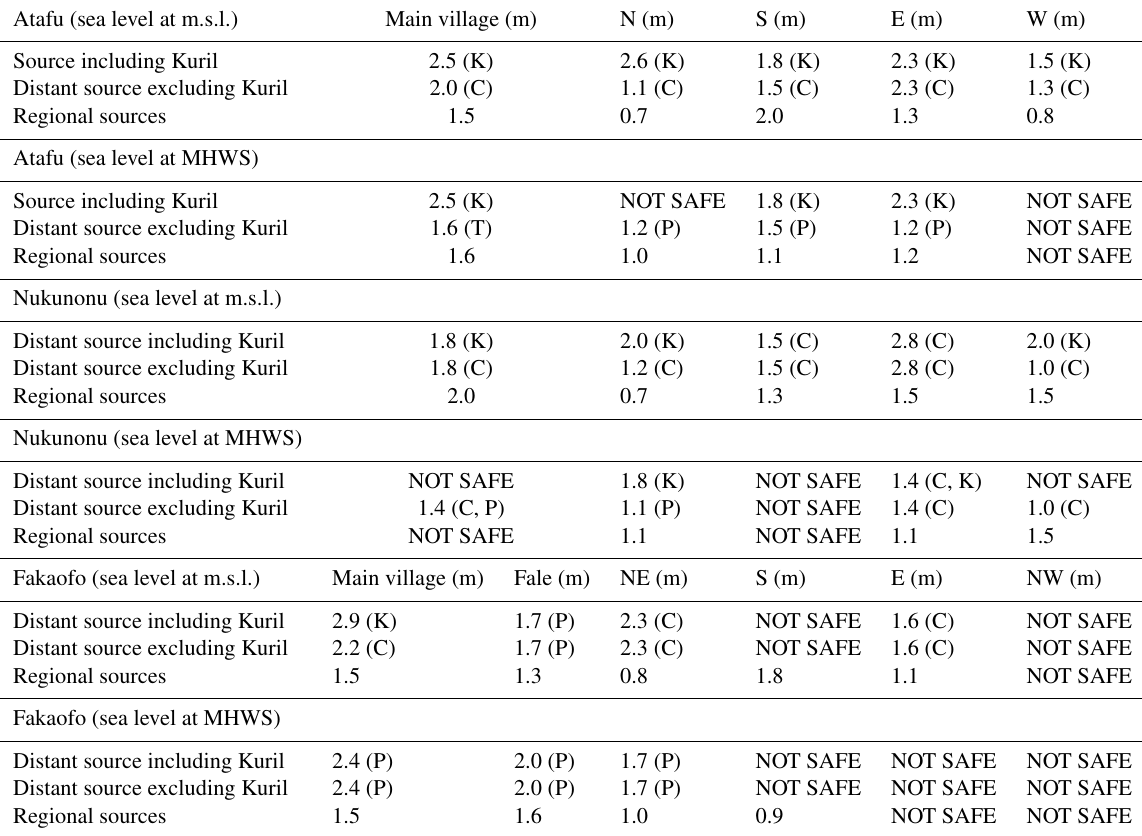
Table 4. Recommended minimum evacuation heights above local sea level (metres) for combined distant sources. To better recognize wave orientation as part of an advisory, four geographic quadrants for each atolls are considered: north (N), south (S), east (E), and west (W). Due to the shape of Fakaofo the northeastern (NE) and northwestern (NW) quadrants of emergent land are noted. Labels refer to the distant sources of Chile (C), Kuril (K), Peru (P), and Tohoku (T), as the earthquake source region that yielded the maximum run-up height from the series of tsunami